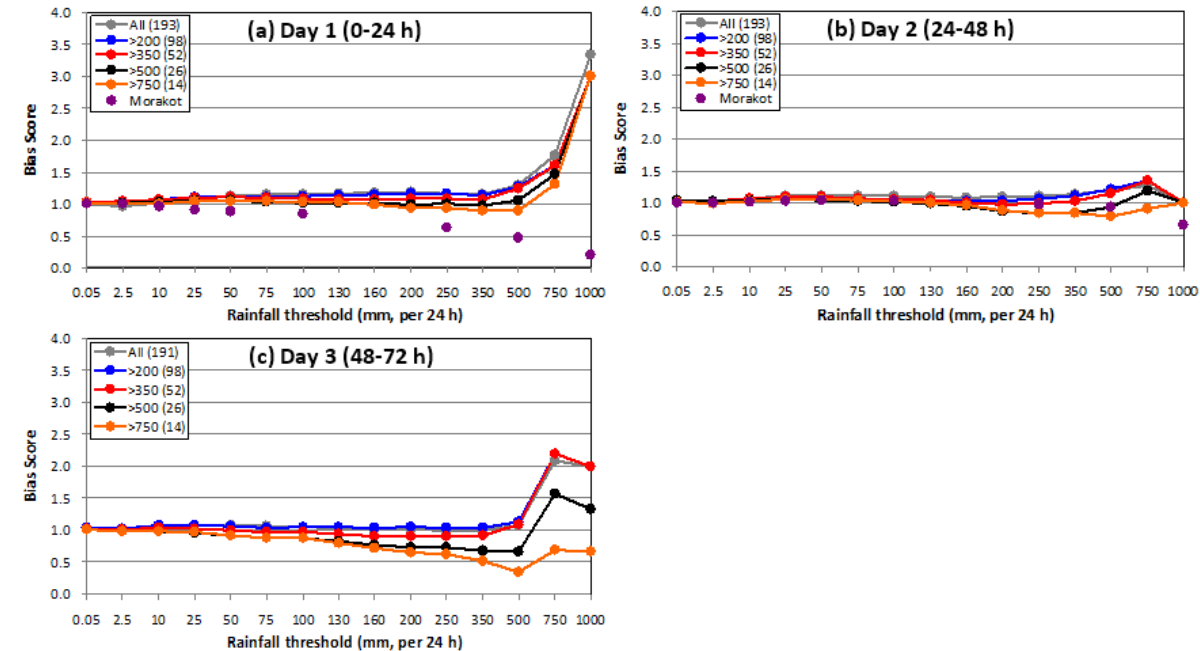
Figure 8. As in Figure 7, but showing the BS for ( a ) day 1, ( b ) day 2, and ( c ) day 3 for the groups with different observed peak 24 h rainfall for typhoons in 2010–2015 and for Morakot (days 1–2 only).